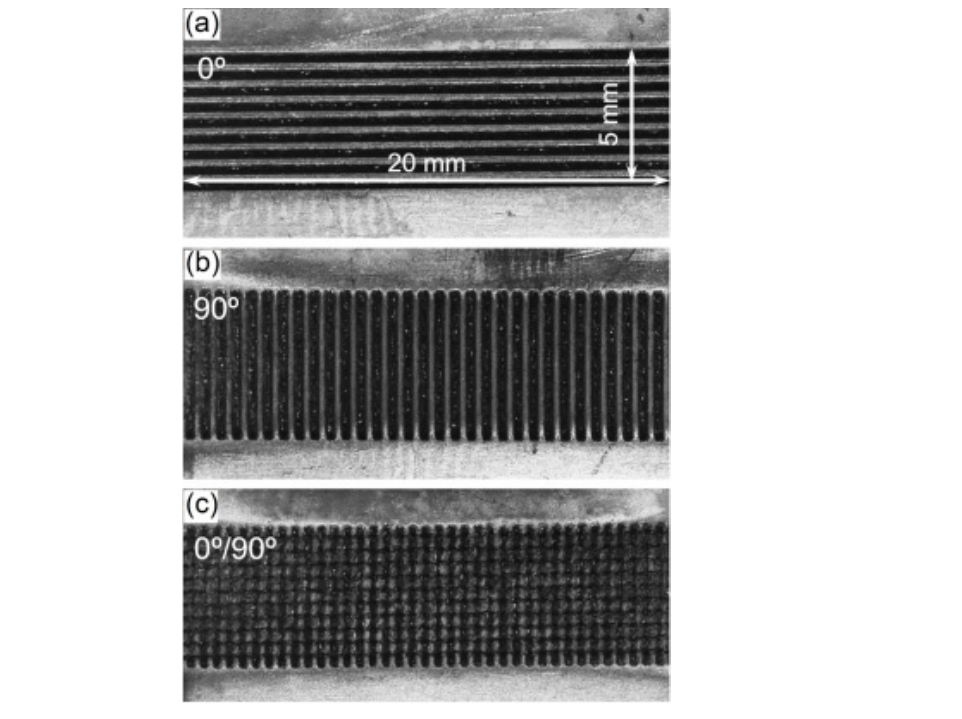
Figure 2. The different laser machined patterns of 0° grating ( a ), 90° grating ( b ), and 0°/90° grid (c) structures on Ti6Al4V surface.